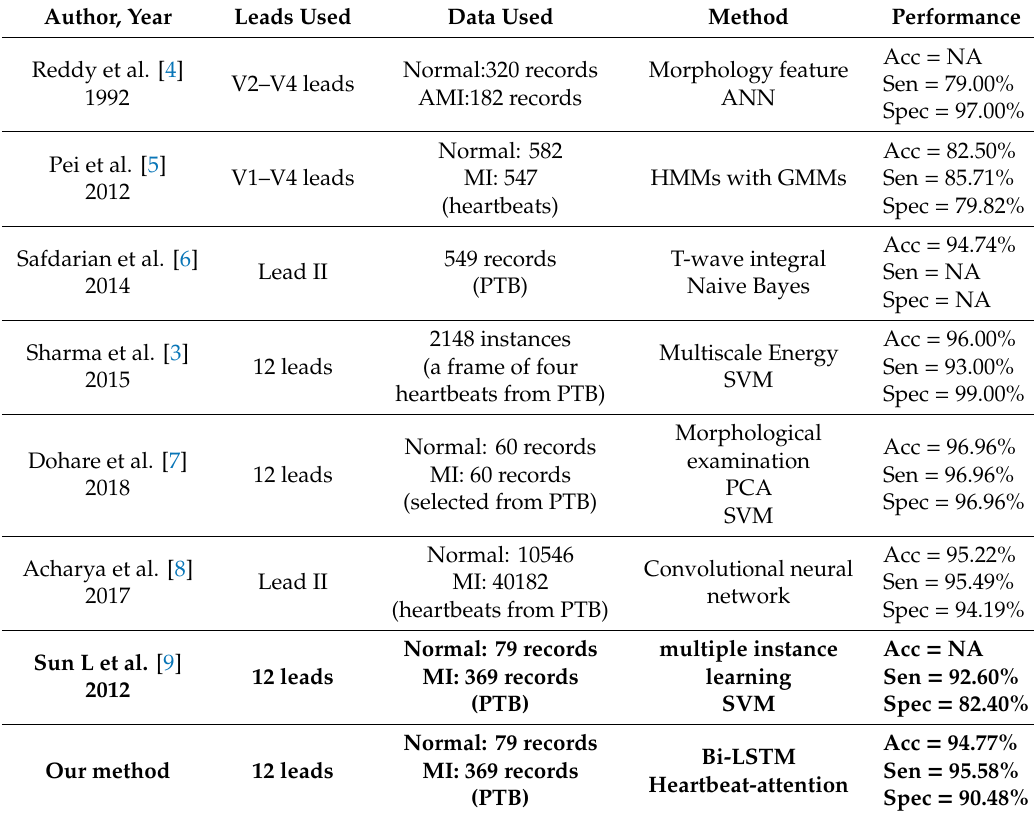
Table 4. Summary of selected studies conducted for the detection of myocardial infarction